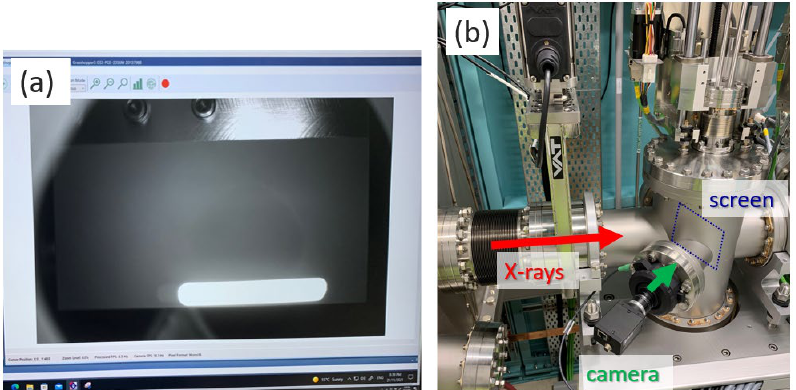
Figure 3. ( a ). Image of the “first light” captured by a visible light camera connected to a computer. ( b ). Diagnostic screen inside vacuum tube (blue dot line square) with visible light camera system (green arrow direction) that captured the X-rays (red arrow direction).